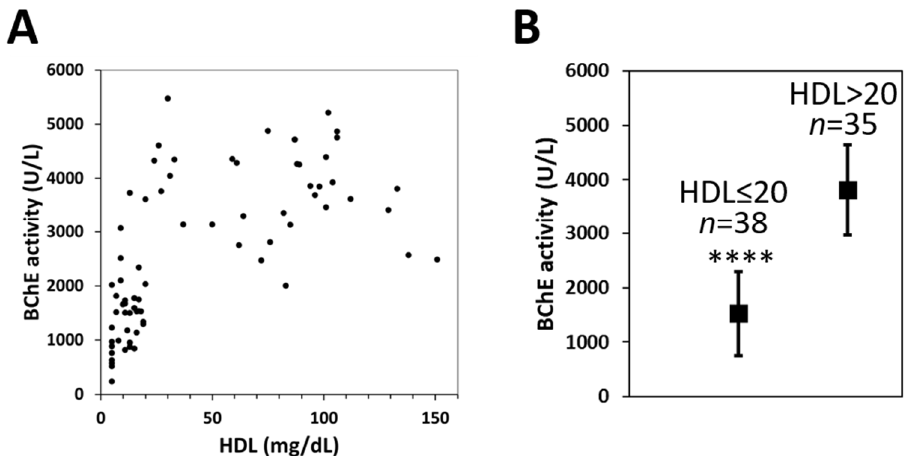
Figure 5. Interrelationship of BChE activity and serum HDL level. ( A ) Each black dot represents the enzyme activity of a single individual. BChE activity was measured by Ellman’s assay as described previously [34]. ( B ) Subjects were divided into 2 groups according to HDL levels. One group ( n = 38) with HDL level ≤ 20 mg/dL, the second group ( n = 35) with HDL level >20 mg/dL; mean values with error bars representing standard deviation (SD), four asterisks (****) represent p -value < 0.0001 calculated using the t -test.